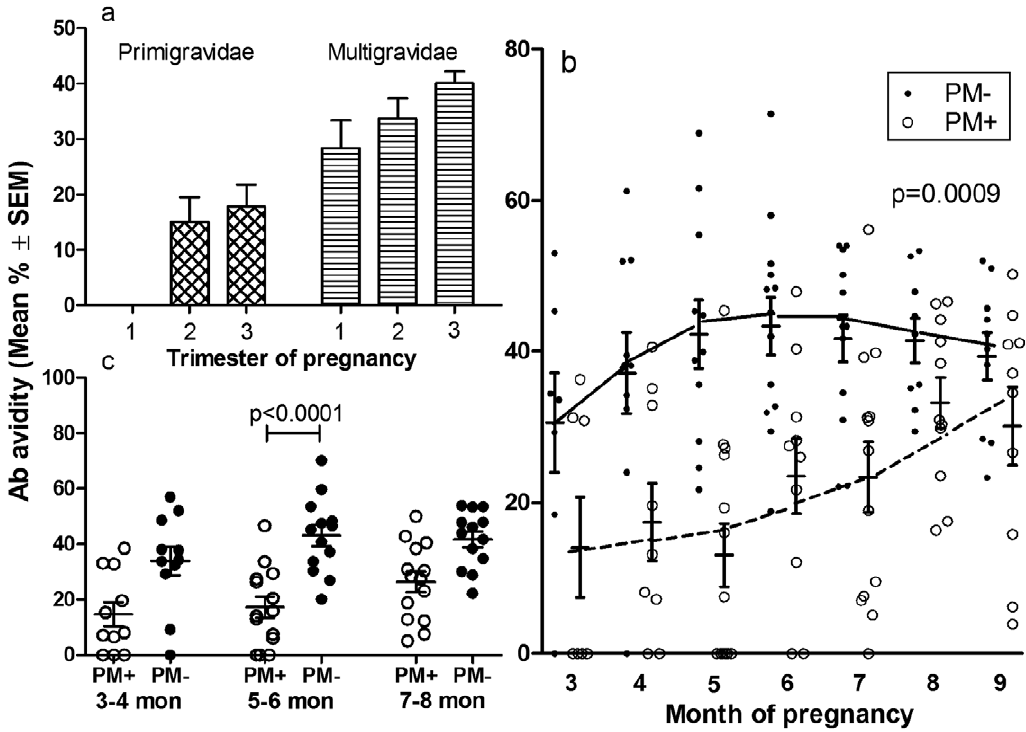
Figure 3. High Avidity Antibodies to VAR2CSA were Associated with Absence of Placental Malaria in Ngali II. ( a ) The proportion (%) of Ab that remains bound to FV2 after incubation with 3M NH 4 SCN (i.e., % high avidity Ab) in the plasma of primigravidae and multigravidae living in Ngali II is shown. Results represent the mean + SEM for 11 to 51 data points per bar. Throughout the course of pregnancy, the proportion of high avidity Ab to FV2 was higher in multigravid than primigravid women (p , 0.0001; multilevel polynomial regression analysis). ( b ) The scattergram shows that the proportion of high avidity Ab to FV2 was highly variable. However, the proportion (%) of high avidity Ab in plasma of women who were PM 2 was significantly higher than in plasma of PM + women during pregnancy (PM 2 , n=13; PM + , n=14) (p=0.0009), based on multilevel polynomial regression analysis. ( c ) A significantly higher proportion of high avidity Ab was present in plasma of PM 2 women than PM + women at 5–6 months (p , 0.0001), but not at 3–4 and 7–8